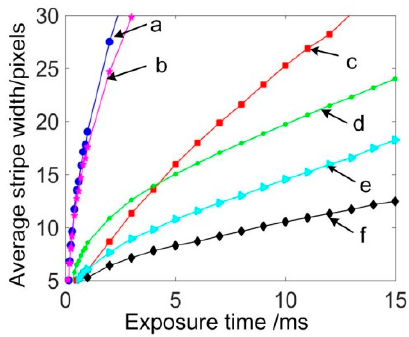
Figure 6. Exposure time vs. ASW curves for corresponding intersection profiles in Figure 5a–f.